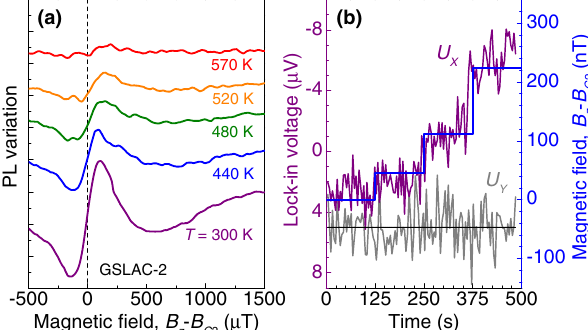
FIG. 4. (a) Lock-in detection of the PL variation in the vicinity 1 . 25 mT) under application of a weak of GSLAC-2 ( B G 2 ¼ oscillating magnetic field, recorded at different temperatures. (b) The in-phase U and quadrature U components of the lock- X Y in photovoltage (left axis) for different magnetic fields (right axis), increased in sub- μ T steps every 125 s. The horizontal line is the U mean value. The maximum field sensitivity is obtained for Y the modulation depth Δ B ¼ 200 μ T and modulation frequency ω = 2 π ¼ 511 Hz. Temperature in (b) is T ¼ 300